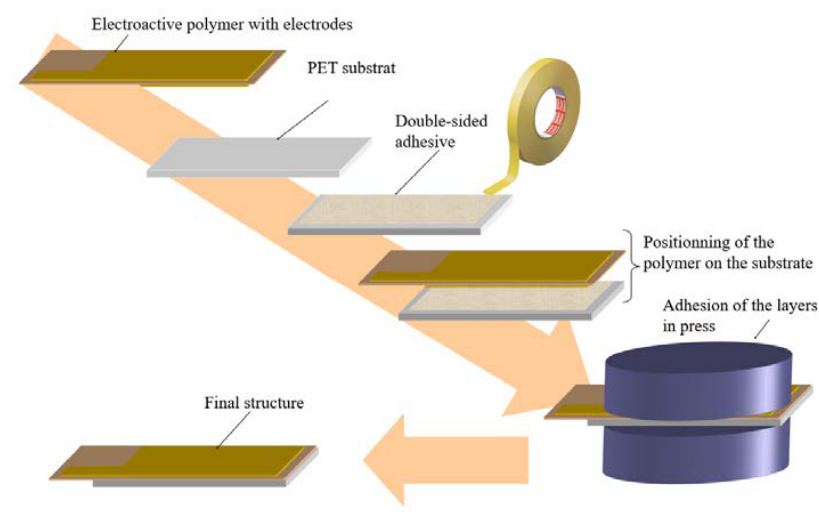
Figure 7. Fabrication process of a P(VDF-TrFR-CTFE) composite actuator.